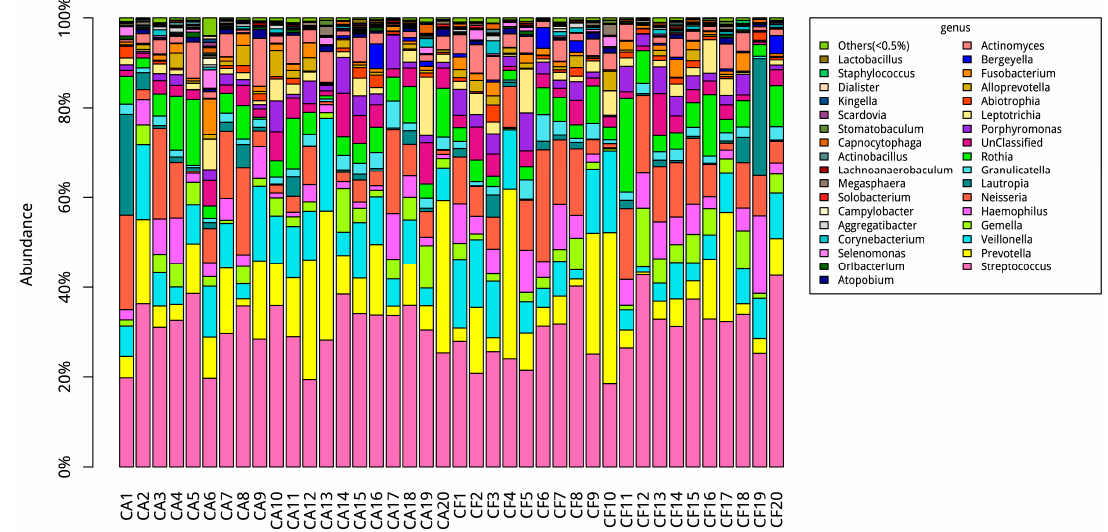
Figure 6. Analyses of the predominant bacterial genera in the caries-affected (CA) and caries-free (CF) groups.